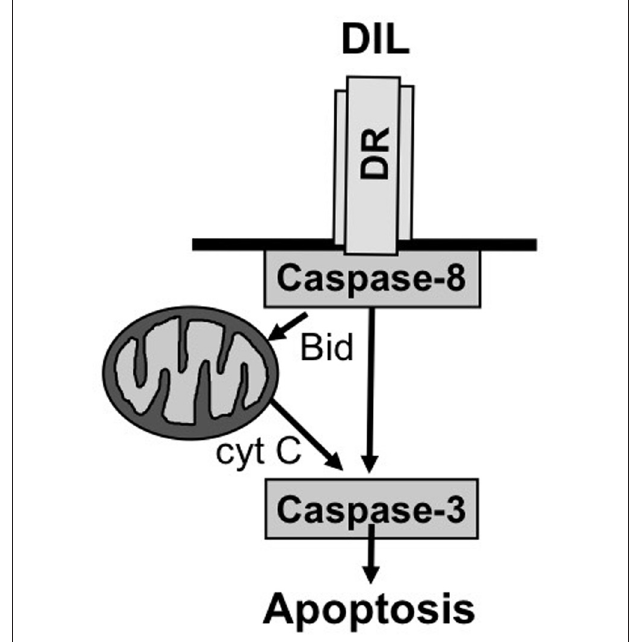
FIGURE 1 | Core apoptosis signaling pathways. See text for more